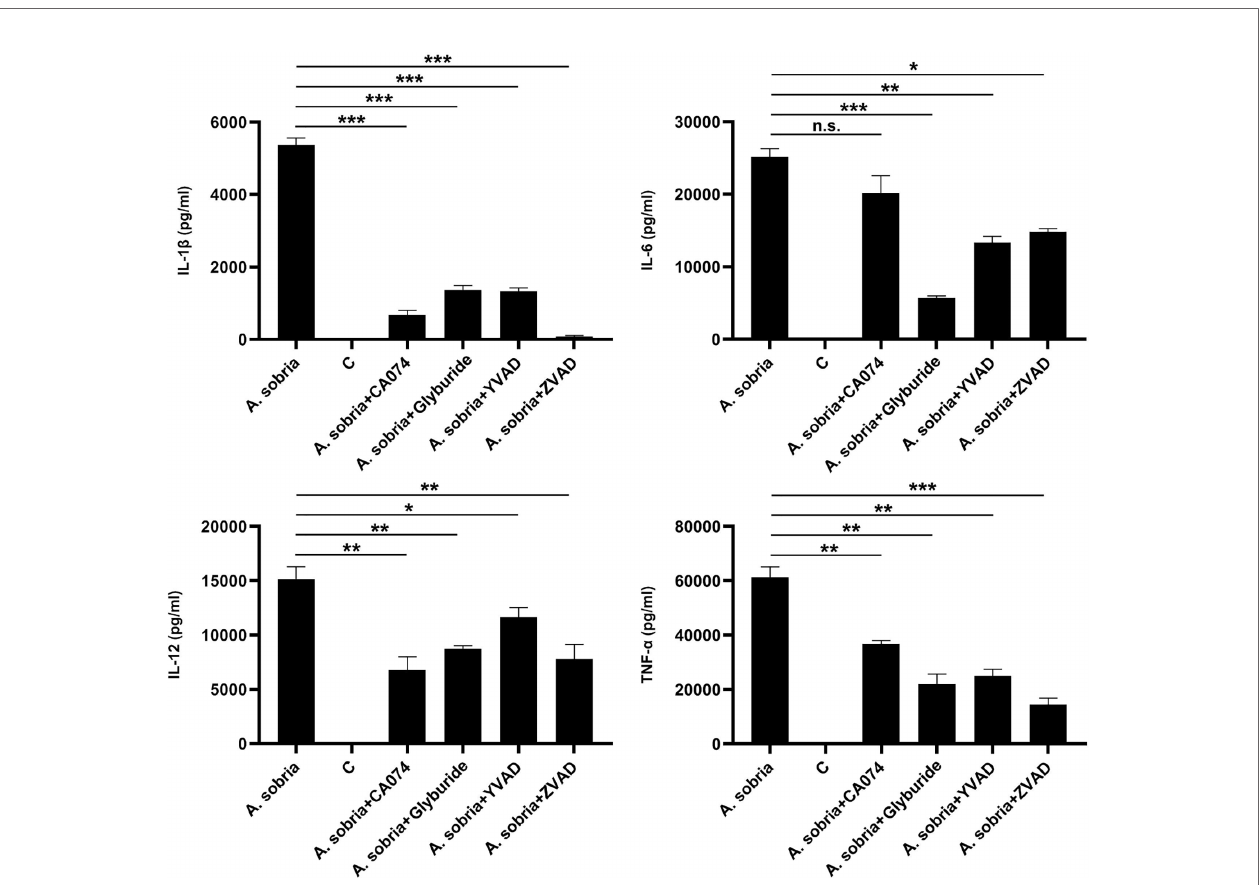
FIGURE 4 | Downregulation of IL-1 b secretion restricted A. sobria – induced pro-in fl ammatory cytokine secretion in PM j s. PM j s (4.5 × 10 6 cells/well in six-well plate) were pretreated with CA-074 methyl ester (25 m M), Glyburide (50 m M), Ac-YVAD-CHO (100 m M), or zVAD-fmk (10 m M) for 1 h, infected with A. sobria (MOI= 10) for 90 min, and then A. sobria was discarded. After washing three times with sterile PBS, PM j s were treated with gentamicin sulfate (100 m g/ml) containing RPMI 1640 maintenance medium for 2 h to kill residual A. sobria and then replaced with gentamicin sulfate (20 m g/ml) containing RPMI 1640 maintenance medium for 12 h. No inhibitor-treated groups were used as positive control group, and no A. sobria infection group was used as negative control (C) group. The supernatants were collected for proin fl ammatory cytokines of IL-6, IL-12, and TNF- a measurement using ELISA. Data were presented as mean ± Standard Deviation from three independent assays with three technical repeats. Signi fi cant differences between positive control group and inhibitor treatment groups were analyzed using SPSS software, and graph was generated using GraphPad Prism 8 software. * represents p<0.05, ** represents p < 0.01, *** represents p < 0.001, and n.s. represents p >